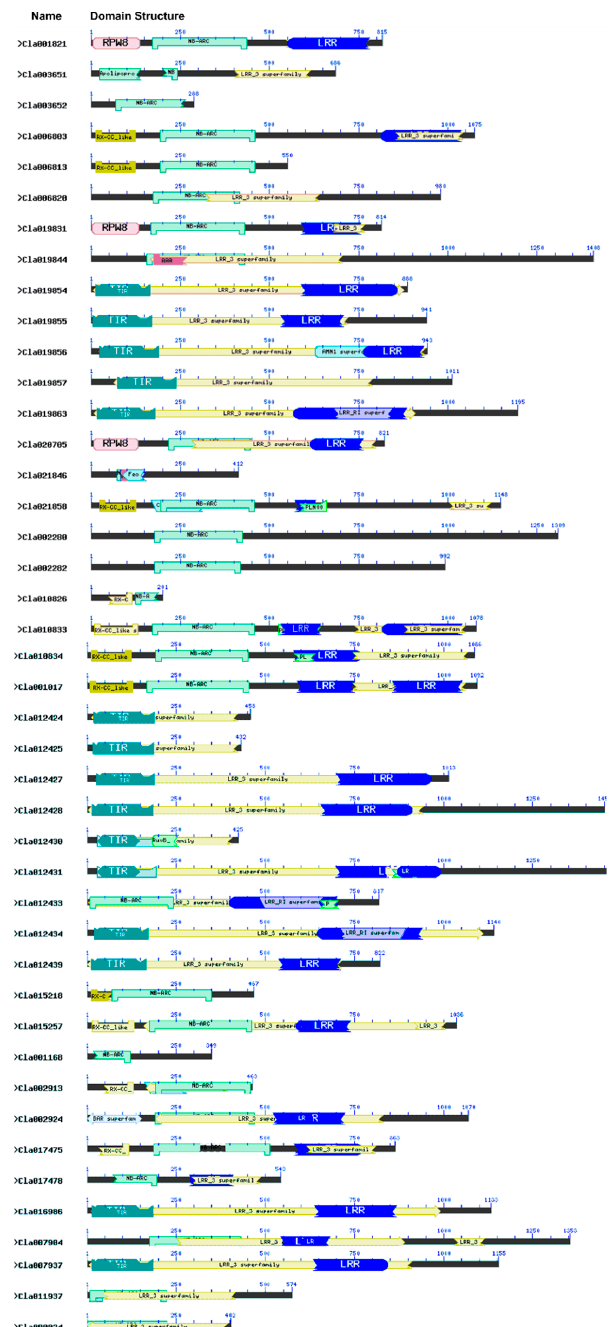
Figure 3. Domains present in NBS proteins in watermelon. The conserved domains were identified using the Conserved Domain Database (CDD) of NCBI against the Pfam v30.0 database (https://www.ncbi.nlm.nih.gov/Structure/cdd/wrpsb.cgi). Detailed descriptions of these domains are provided in Table 2. Specific domains in each protein are shown in the diagram.